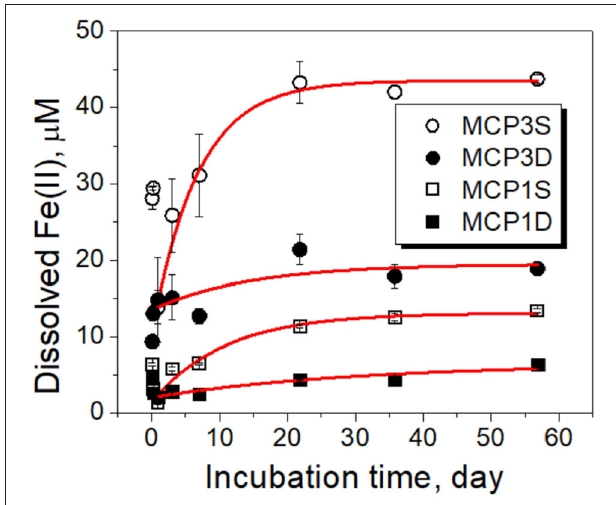
FIGURE 4 | Dissolved Fe(II) concentrations over time during incubation experiments. Black symbols are the experimental data, and red lines are the fitted results with the first-order rate (Equation 4). The error bars represent one standard deviation from duplicate experiments.